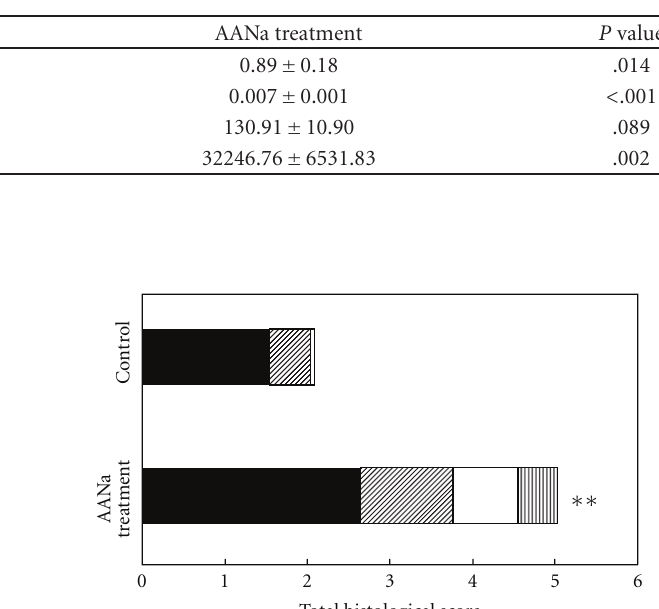
Table 2: E ff ects of 0.5mg/kg aristolochic acid sodium (AANa) treatment on inulin in rabbits ( n = 10).